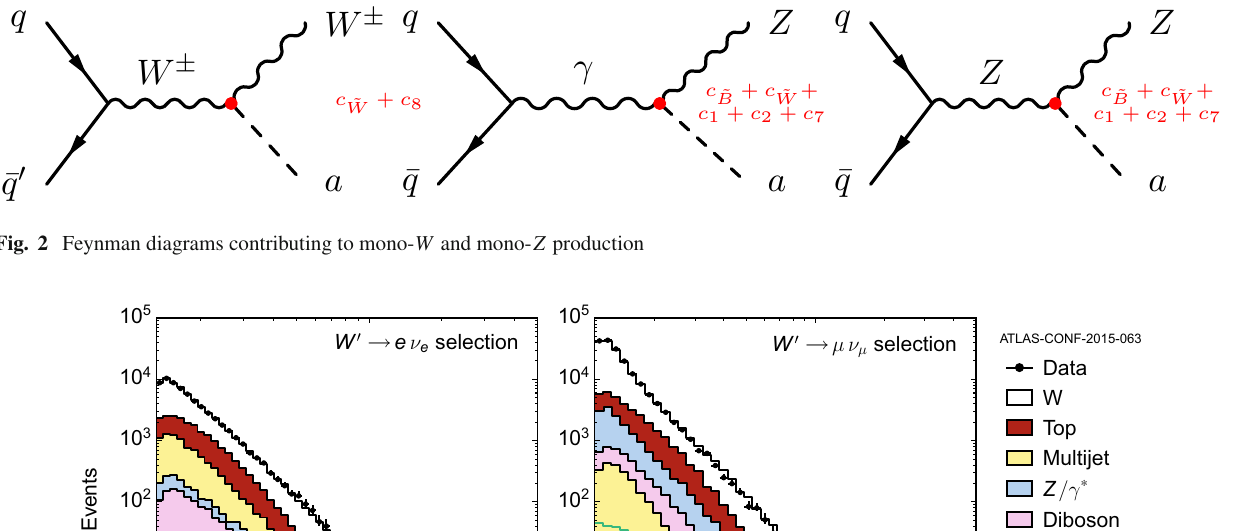
Alsoshownarethebinnedexperimentaldataanddominantbackgrounds from the 13 TeV ( 3 . 3fb − 1 ) ATLAS analysis